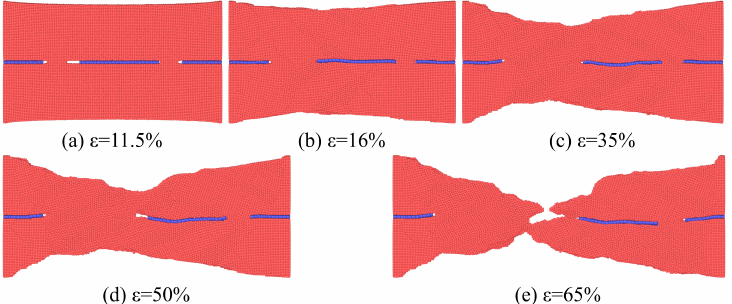
Figure 12. Atomic configuration diagram of Gr/Cu-2 under different strains during stretching. ( a ) ε = 11.5%, ( b ) ε = 16%, ( c ) ε = 35%, ( d ) ε = 50% and ( e ) ε = 65%.